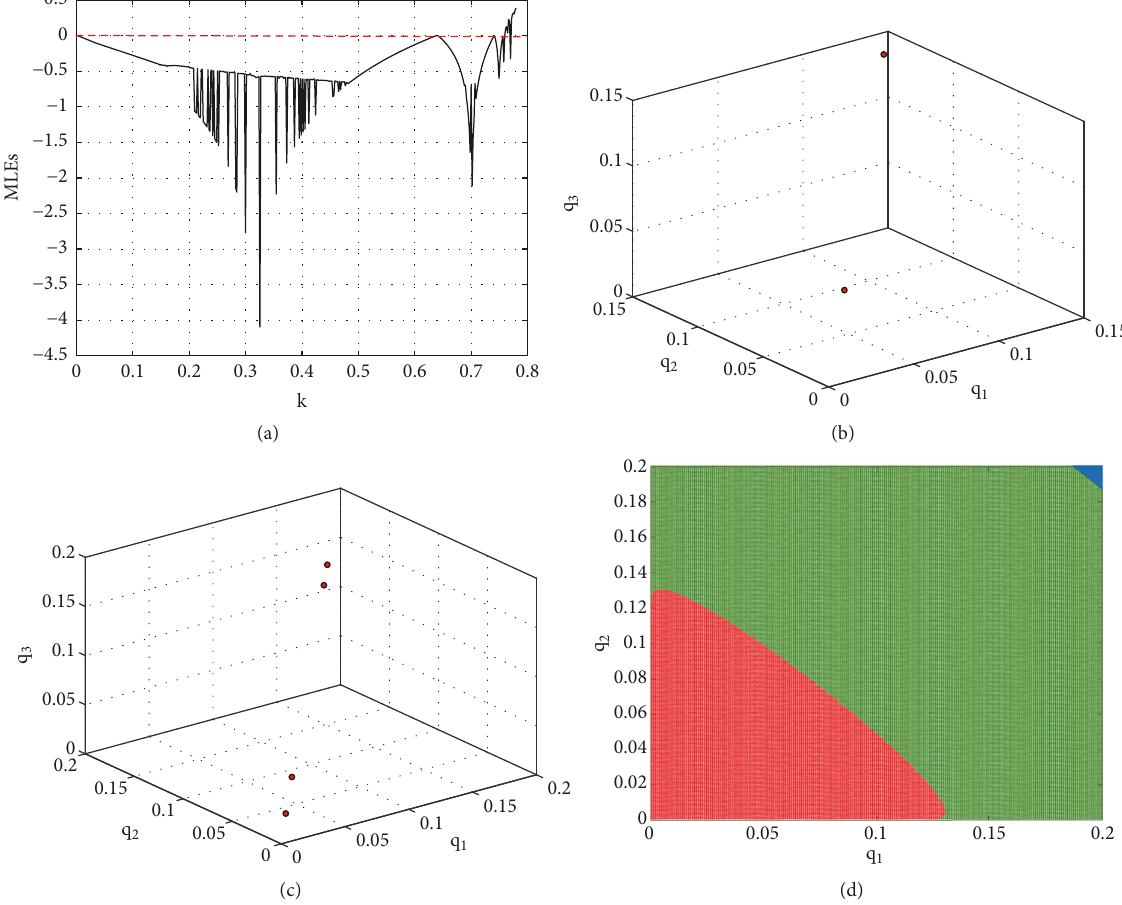
Figure 4: (a) Maximum Lyapunov exponents with respect to 𝑘 at (𝑎,𝑐,𝛼,𝑞 0,1 , 𝑞 0,2 ,𝑞 0,3 , 𝑞 0,4 ) = (0.625, 0.11, 0.75, 0.19, 0.15, 0.13, 0.11) . (b) Phaseportraitoftheperiod2-cycleofsystem(6) at (𝑎, 𝑐, 𝑘, 𝛼, 𝑞 0,1 ,𝑞 0,2 ,𝑞 0,3 , 𝑞 4 ) = (0.625, 0.11, 0.7, 0.75, 0.19, 0.15, 0.13, 0.11) .(c)Phaseportrait of the period 4-cycle of system (6) at (𝑎, 𝑐, 𝑘, 𝛼, 𝑞 0,1 ,𝑞 0,2 , 𝑞 0,3 , 𝑞 4 ) = (0.625, 0.11, 0.75, 0.75, 0.19, 0.15, 0.13, 0.11) . (d) The basin of attraction of the period 2-cycle at (𝑎,𝑐,𝑘,𝛼,𝑞 3 , 𝑞 4 ) = (0.625, 0.11, 0.7, 0.75, 0.13, 0.11) .